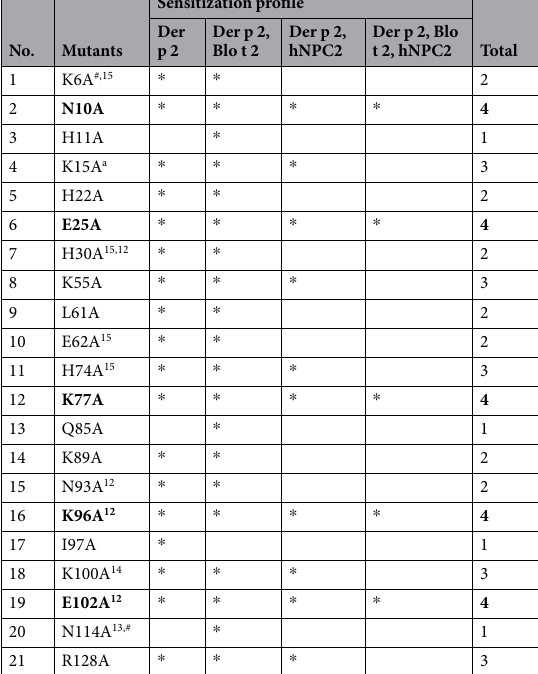
(Fig. 1a), where mutant K96A of Der p 2 showed the lowest IgE binding capacity among Der p 2 sensitized individuals. Mutant E102A also showed reduced IgE binding compared to Der p 2, although to a lesser extent. Differences between IgE binding to wild type Der p 2 and mutant K96A or mutant E102A were statistically significant (p < 0.0001). An inhibition ELISA was next used to investigate the lack of serum IgE reactivity to mutants E102A and mis- folded Der p 2. IC 50 of mutant E102A was at least 4-fold higher, while for K96A it was 16-fold higher compared to WT Der p 2 in all allergic individuals tested (Table 3, Fig. 2d,e). Mouse IgG antibodies raised against mutants E102A and K96A are able to block allergic indi- viduals’ IgE binding to WT Der p 2. One of the first indications of successful immunotherapy in humans is the increase in antigen specific IgG levels, which competes and blocks IgE-binding to the allergen 17 . To investigate the effectiveness of mutants E102A and K96A as potential hypoallergens, specific IgG antibodies were raised in mice, by immunization with WT or mutants of Der p 2, and inhibition of human IgE binding to WT Der p 2 was assessed using ELISA (Fig. 3a). Mouse IgG antibodies against WT Der p 2 showed almost complete inhibition of human IgE binding to Der p 2 at > 90% inhibition. Similar inhibitory effect was also observed when IgG antibod- ies against mutants E102A and K96A were used to inhibit IgE binding to Der p 2, suggesting that both mutants were capable of generating blocking antibodies. IgG antibodies from mice immunized against hNPC2 and PBS could not inhibit the binding of allergic individuals’ IgE to Der p 2 (Fig. 3a). of mutants E102A and K96A to stimulate the proliferation of peripheral blood mononuclear cells (PBMCs) from dust-mite allergic individuals. Both E102A and K96A were able to stimulate PBMC proliferation comparable to WT Der p 2 in three allergic individuals tested, indicating the Der p 2 mutants retained functional T-cell epitopes (Fig. 3b). To determine the subtype of T-cells that proliferated, we measured the concentrations of IFN- γ (Th1 cytokine) and IL-13 (Th2 cytokine) released into the cell culture supernatant (Fig. 3c). Additional T-cell prolif- eration studies were performed on patients showing similar results, with mean stimulation index ranging from 1.5–2.1 and the mean IFN-gamma:IL13 ratio ranging from 0.2–0.8. No significant differences were observed between the wild type Der p 2 allergens and the comparative mutants. As the Th1:Th2 cytokine ratio when stim- ulated with WT Der p 2 or its mutants were not statistically significant, a distinction of a dominant T-cell subtype could not be determined.